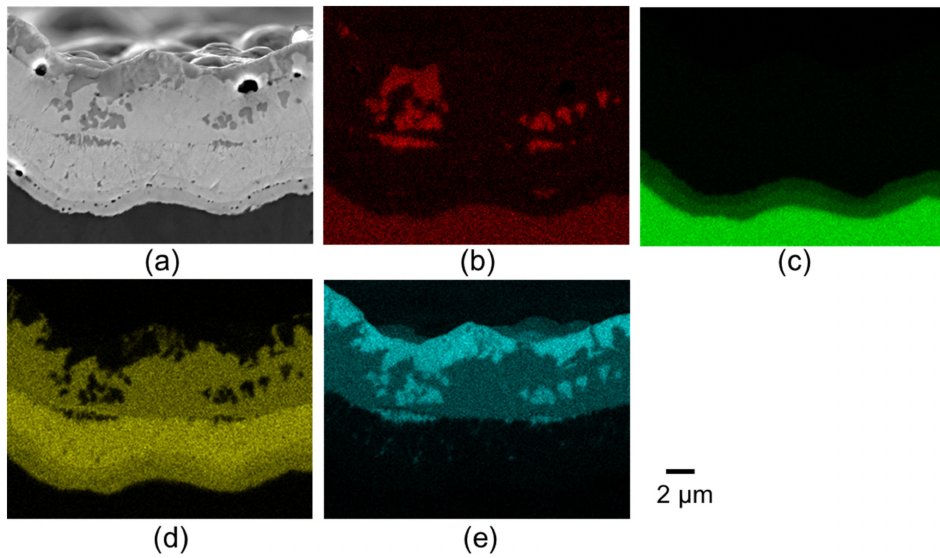
Figure 7. Cross-sectional SE image and EDS mappings for Ti-Cr multilayer coating irradiated at 573 K, 2.85 × 10 20 ions /m 2 with Si 2+ ion at 5.1 MeV. ( a ) Cross-sectional SE image. ( b – e ) EDS mappings for the same specimen as in ( a ) obtained from the separated peak signals of the: ( b ) C K line, ( c ) Si K α line, ( d ) Cr L line, and ( e ) Ti L